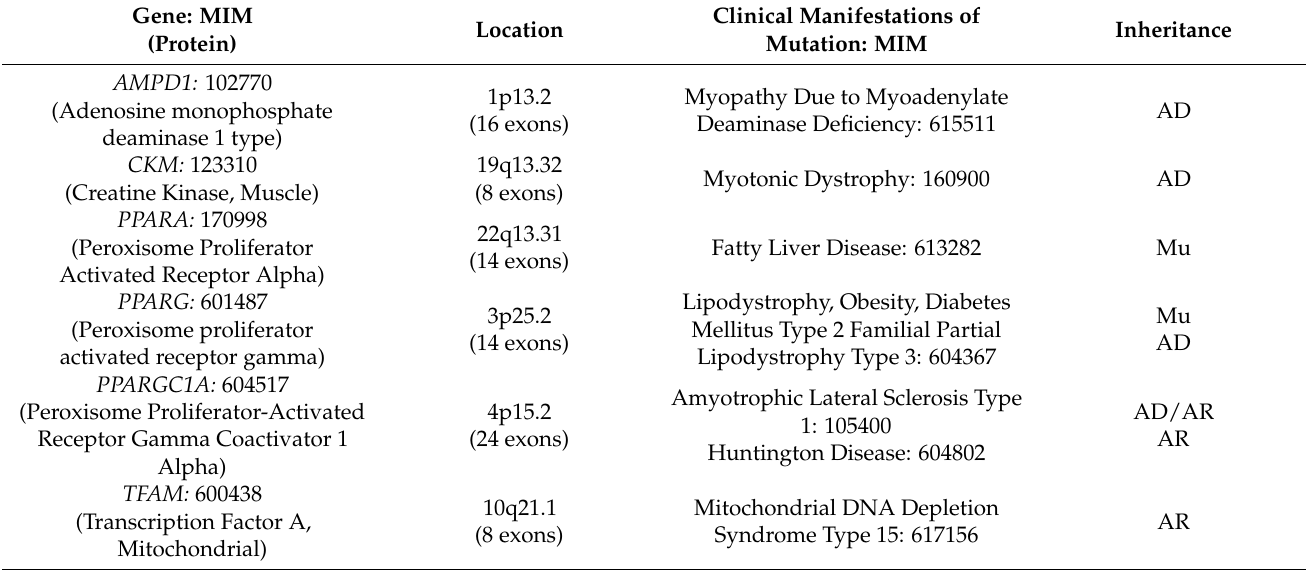
Table 1. Genes responsible for myogenesis and skeletal muscle metabolism and diseases caused by their mutations (adapted from